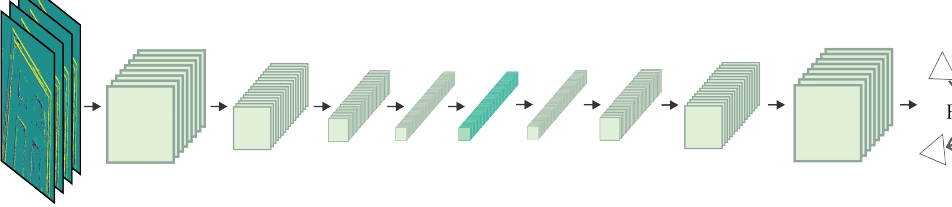
Figure 2. Network for camera rotation estimation, simplified from EV-FlowNet v2